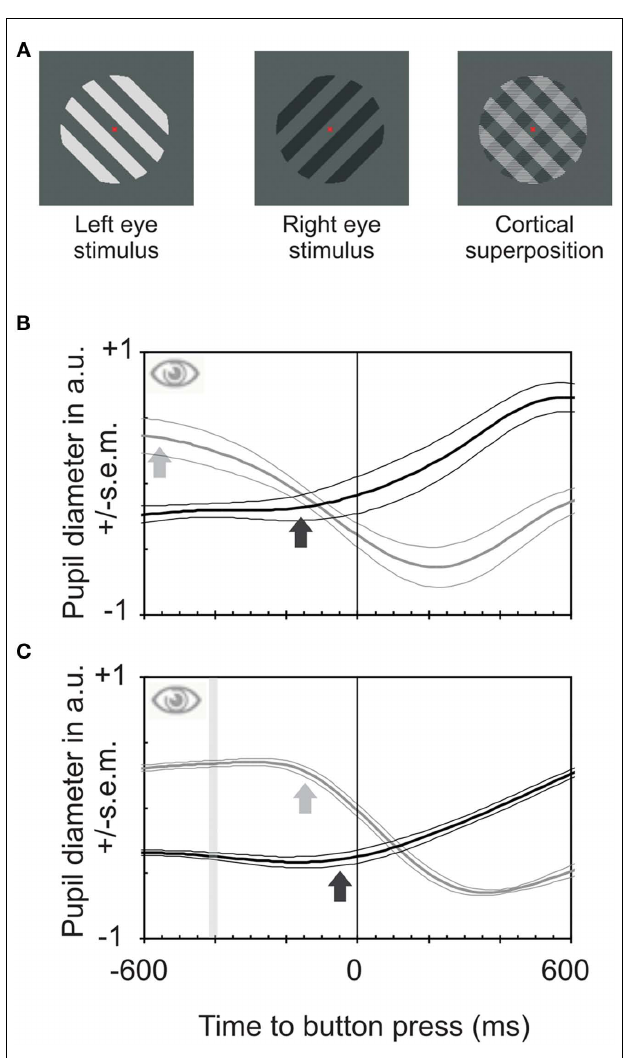
FIGURE 1 | Stimuli used and pupil reactions obtained during binocular rivalry and between stimuli of differing luminances. (A) Stimuli used to elicit binocular rivalry. An oblique darker grating was projected to one eye, a perpendicular brighter one to the other eye, resulting in alternation of perception between the two stimuli. (B) Pupil reactions (means and SEM for four observers) to a change in subjective perception between the two gratings relative to time of button presses during binocular rivalry.The black line shows the relative pupil response for transitions from bright to dark and the gray line transitions from dark to bright. Pupil constrictions start on average about 590ms before the button presses (gray arrow); pupil dilations start about 120ms before the button presses (for movement onset estimates see Bergamin and Kardon, 2003). Hence the pupil reacts to internally triggered transitions between percepts much earlier than button presses do. (C) Pupil responses to a change in physical stimulus properties in both eyes from dark to bright or vice versa.The bar indicates the time of change of physical stimulus properties. It is an interval rather than a fixed point in time because data were averaged relative to button presses and reaction times vary slightly (both intra-individually and between observers). The constriction starts about 120ms before the button is pressed (gray arrow); dilation starts only marginally before the button press. Hence reaction times for pupil responses and button presses are quite similar for externally caused changes of perception.The lead of pupil responses in (B) is not mainly due to a faster reaction time of the